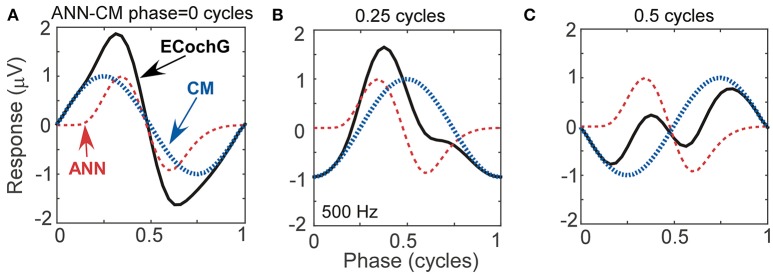
Waveforms generated using simulated signals varied in phase. (A) When the CM and ANN are in phase, the waveform is only slightly distorted, and the amplitude is maximal. (B) When the CM and ANN are ¼ cycle out of phase, the distortion increases. (C) When the CM and ANN are ½ cycle out of phase the distortion is even greater and the overall response magnitude is at a minimum.